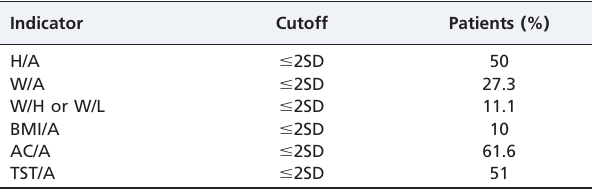
Table 3 - Frequency of malnutrition in 60 children after liver transplantation, according to the different indicators (Z) used in the anthropometric